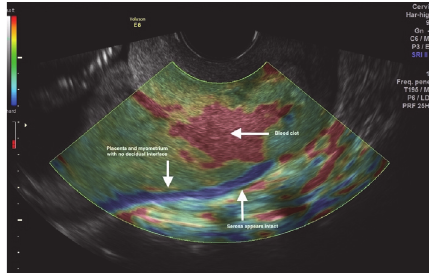
Figure 1: Elastogram demonstrating placental invasion into myo- metrium (placenta increta) with an intact uterine serosa.